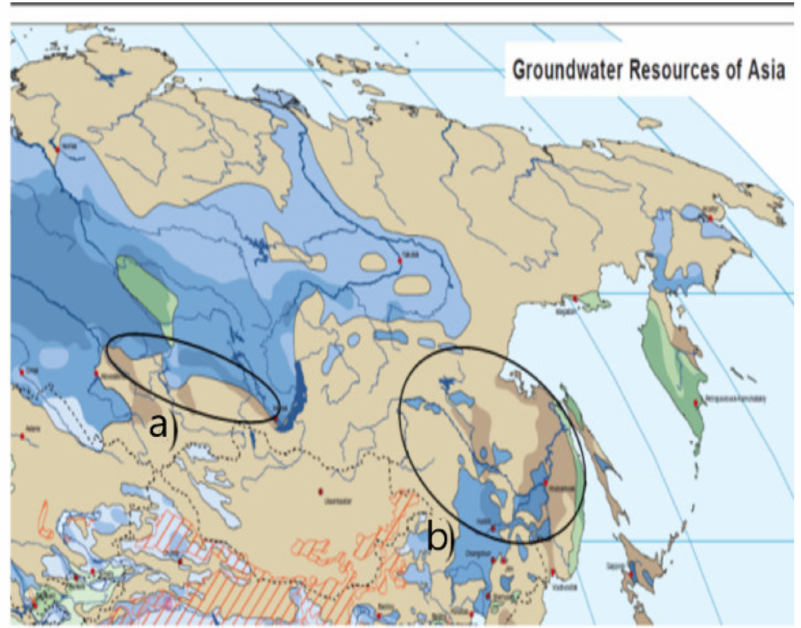
Figure 20. A groundwater map of both the Amur River channel and the upper reaches of the Yenisei River (marked by closed areas), which lie close to the earth’s surface and are characterized by instability in the hydrological regime: (a) at the junction of the Baikal and Caledonian folding; (b) at the junction of Baikal, Herzian and Mesozoic folding (according to the World-Wide Hydrogeological Mapping and Assessment